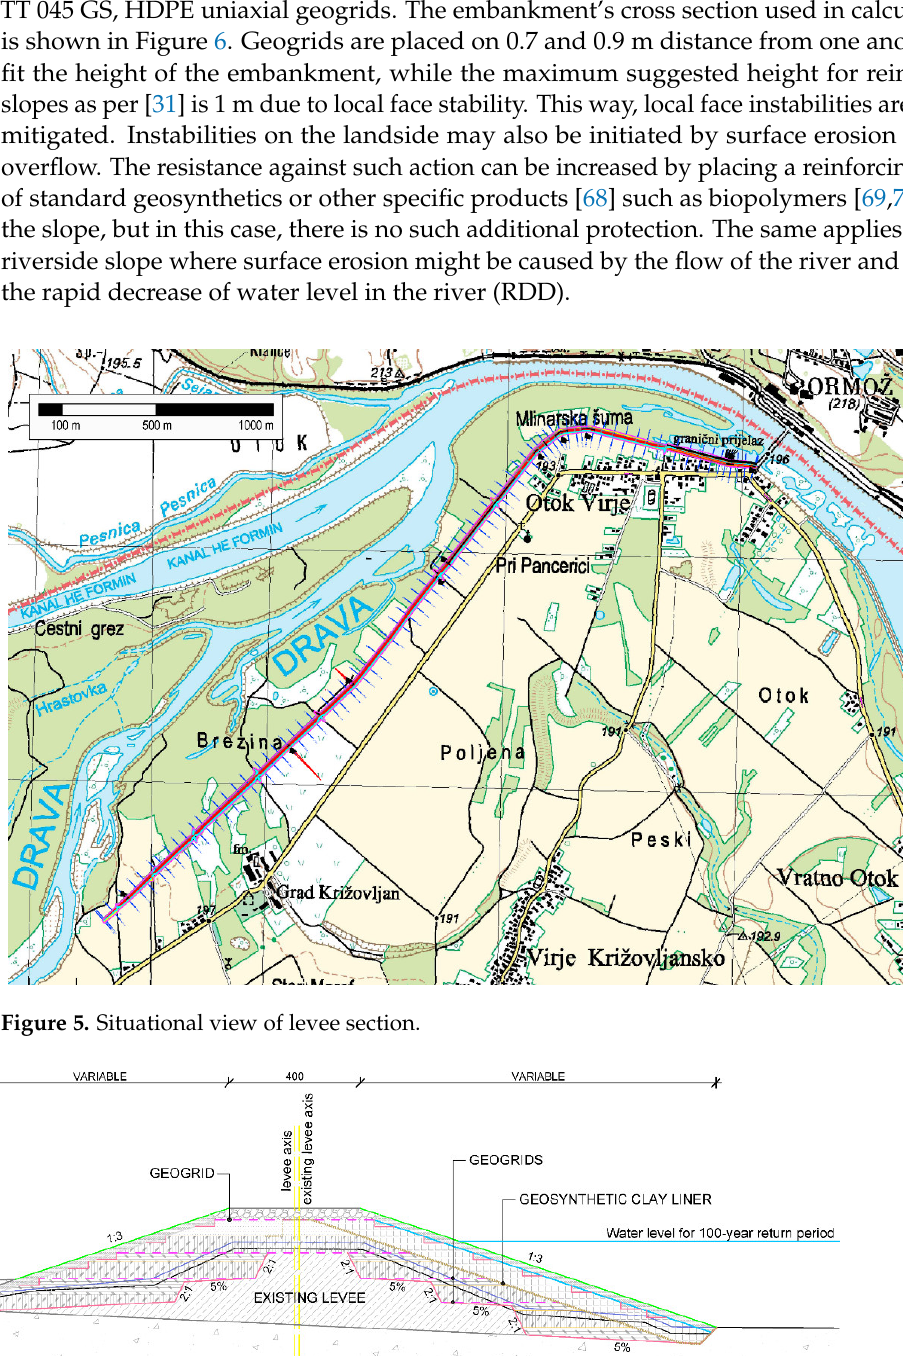
Table 1. Deterministic safety factors for the cross section of interest in various design situations.